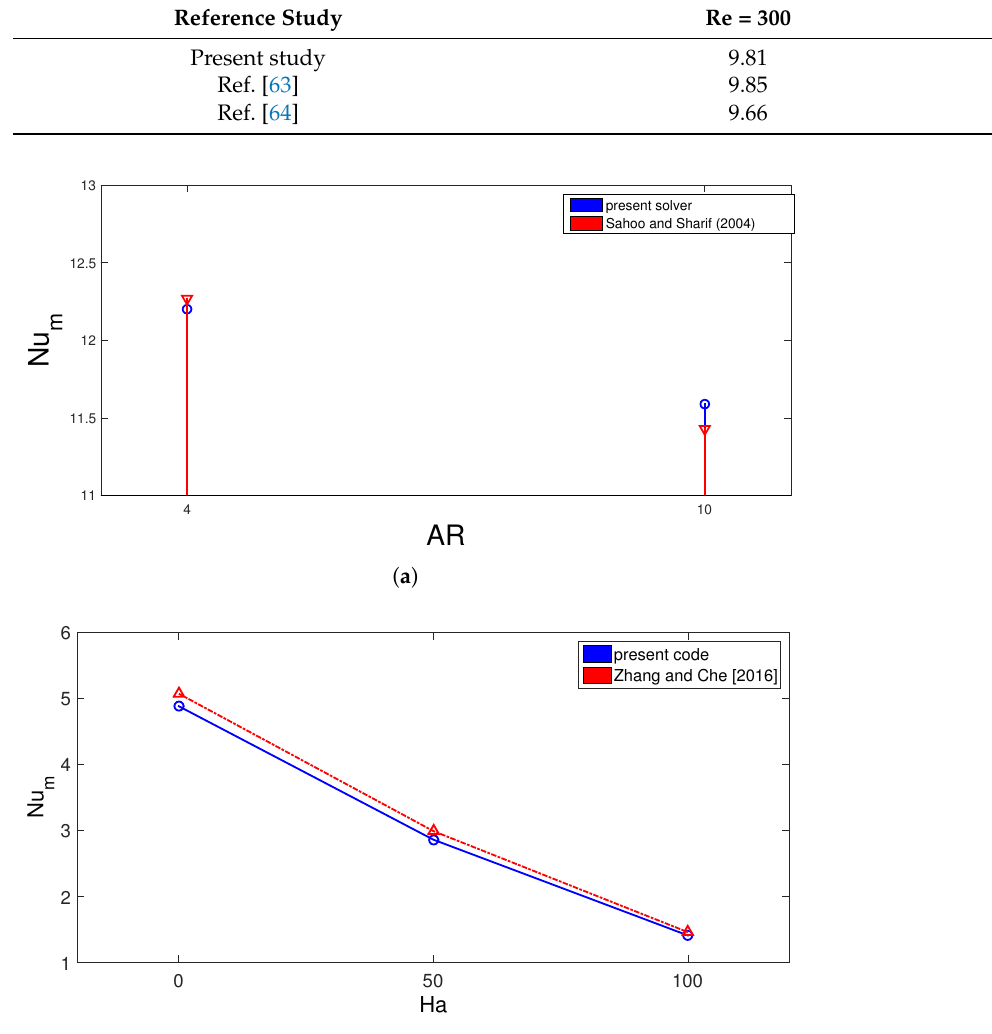
Figure 3. The average Nu comparison for slot j-im cooling at two values of aspect ratio (AR) where the surface is kept at an isothermal hot temperature (reference values of [62] were used) ( a ) and comparisons of average Nu for convective HT with varying MaF strengths (reference values of [65] were used) ( b